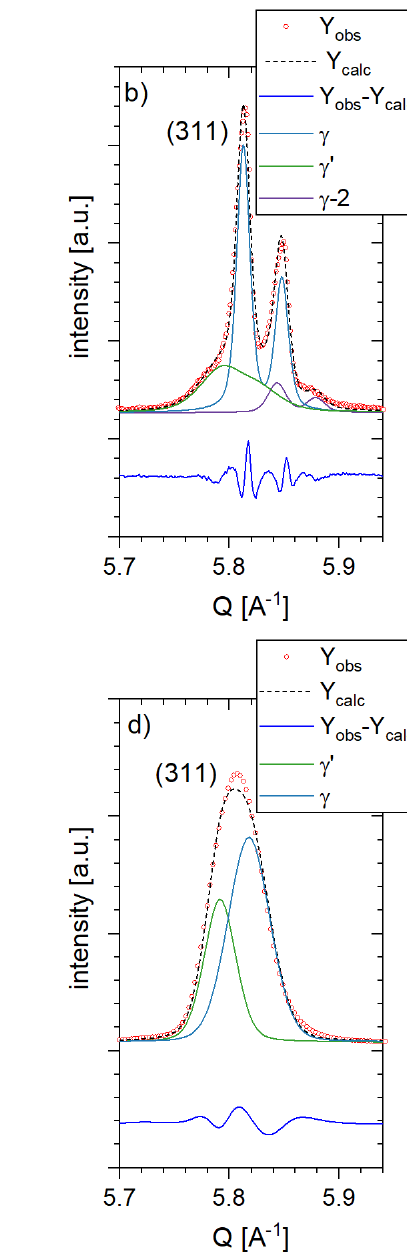
Figure 3. Rietveld refinement of the VDM ® Alloy 780 samples tested at room temperature, with observed data (red circles), calculated data (black line), and difference plot (blue line), together with the position of the Bragg reflections of γ and γ′ for ( a ) the XRD and ( c ) the synchrotron measurements. A detailed view of the refinement of the (311) diffraction peaks is shown for the XRD- and synchrotron measurements in ( b , d ). In these diffractograms, the simulated patterns for the γ, γ′ and, if present, γ-2 phases are also shown. The calculated γ′ weight fraction was in good agreement for both measurements, as shown in the tables in the insets of Figure 3a,c. Furthermore, the values in this work were